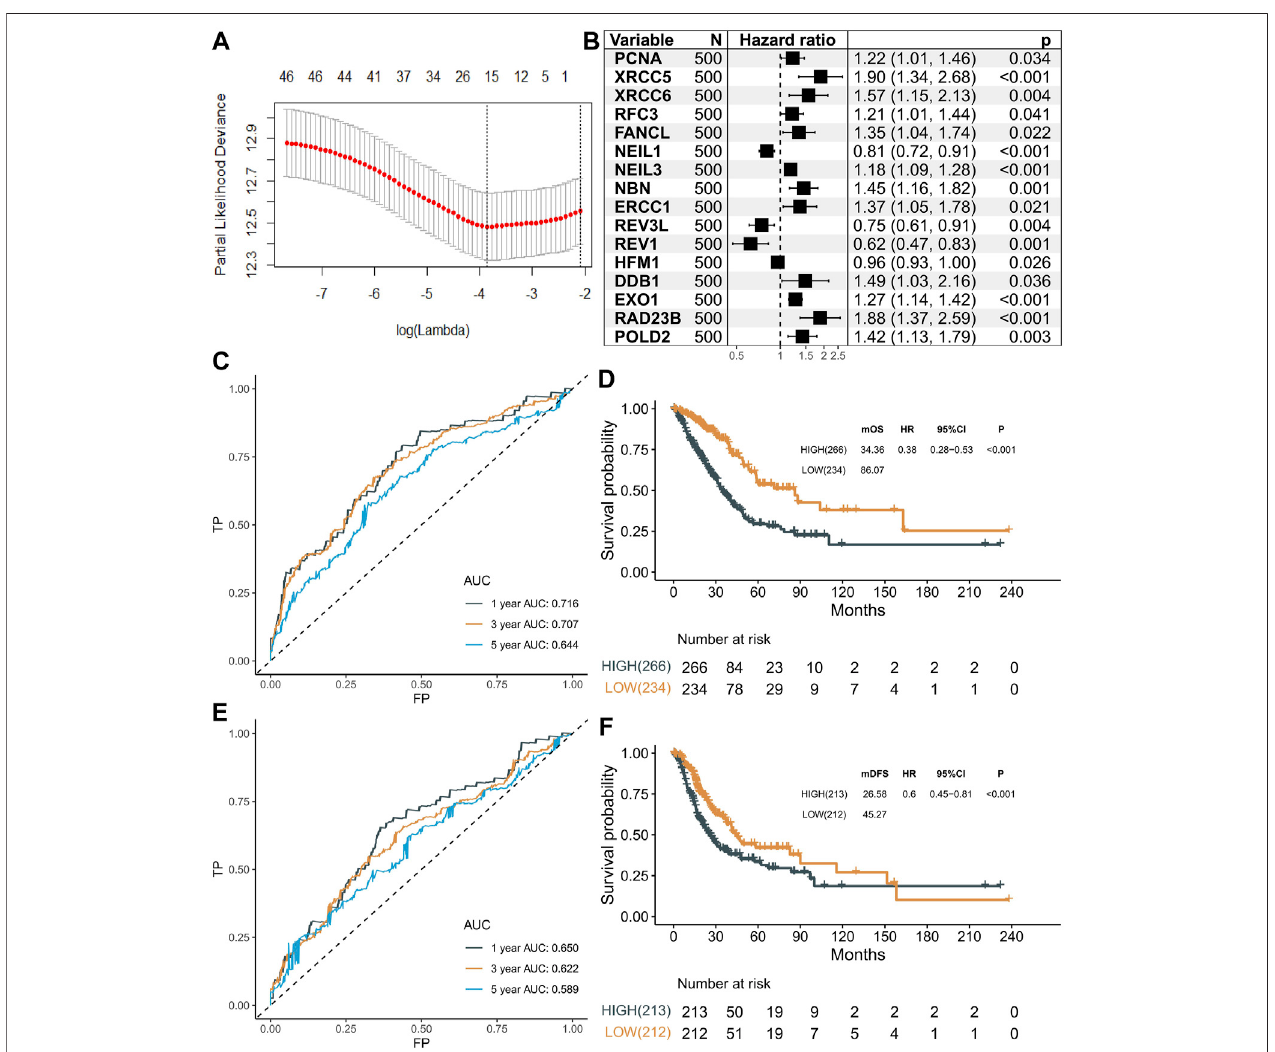
FIGURE1 | Selection ofprognostic markers. (A) Tuning parameter ( λ ) selection in theLASSOmodel using 10-fold cross-validationvia minimum criteria. (B) Forest plot showing the results of univariable Cox regression analyses. (C) Predictive value of 16 genes in the overall survival of patients in the LUAD dataset. (D) Kaplan – Meier curves of overall survival for high- and low-risk patient groups in the TCGA – LUAD dataset. Patients were divided into two groups with a cutoff score of 21.96. (E) Predictive value of 16 genes in the disease-free survival of patients in the LUAD dataset. (F) Kaplan – Meier curves of disease-free survival for high- and low-risk patient groups in the TCGA – LUAD dataset. Patients were divided into two groups with a cutoff score of 21.96.